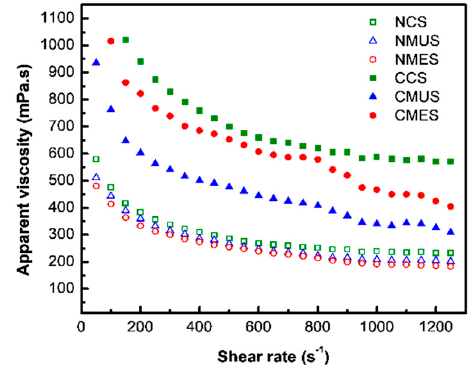
Figure 1. Apparent viscosity as a function of shear rate for the different samples.